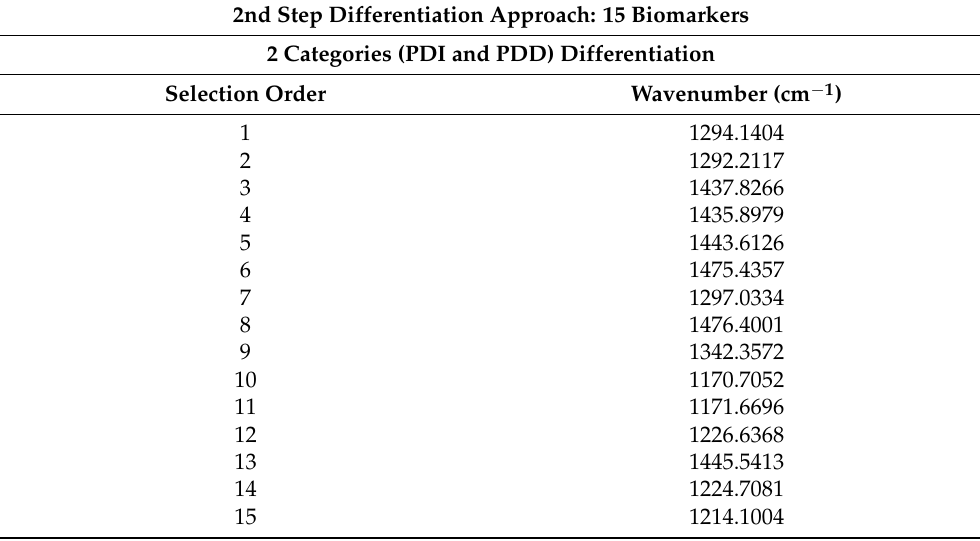
Table 4. Discriminant wavenumbers (in order of selection) corresponding to the SELECT-LDA classifi- cation developed from IR spectra of plasma samples for the differentiation of PD progression